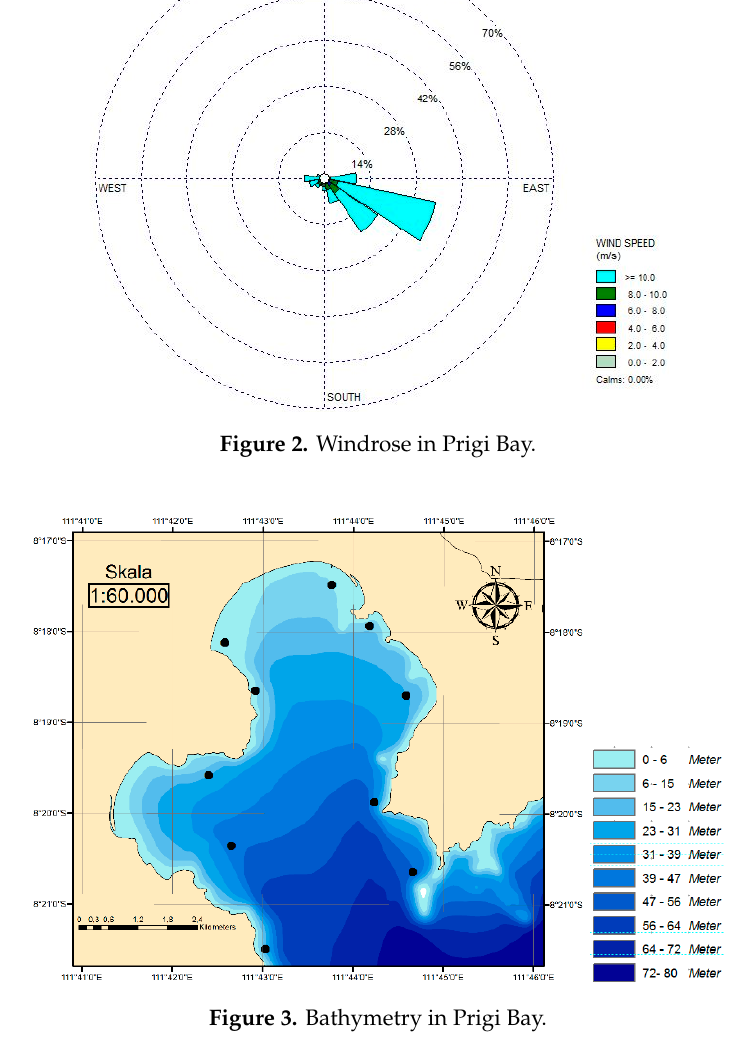
Figure 3. Bathymetry in Prigi Bay.